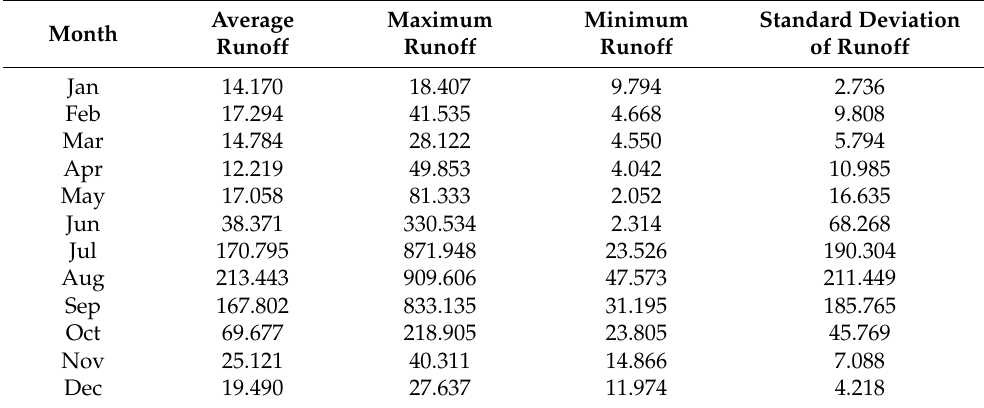
Table 1. The statistical characteristics based on monthly discharge in Linyi hydrological